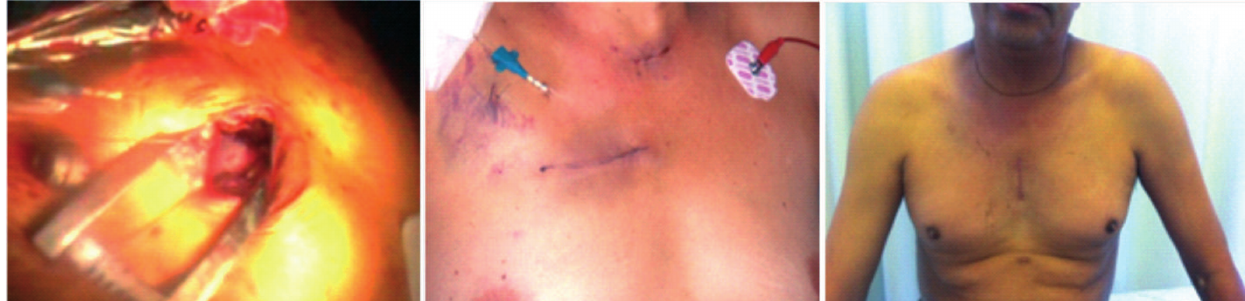
Fig. 4 - Opções de incisões cirúrgicas para acesso à valva aórtica. Da esquerda para direita: exposição do segundo intercosto com linha axilar anterior e trocater para toracoscópio. Incisão torácica anterolateral direita, incisão mediana alta para hemiesternotomia